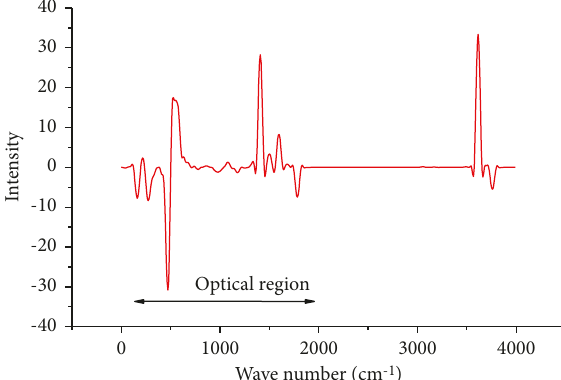
Figure 10: VCD spectrum of BDSC.